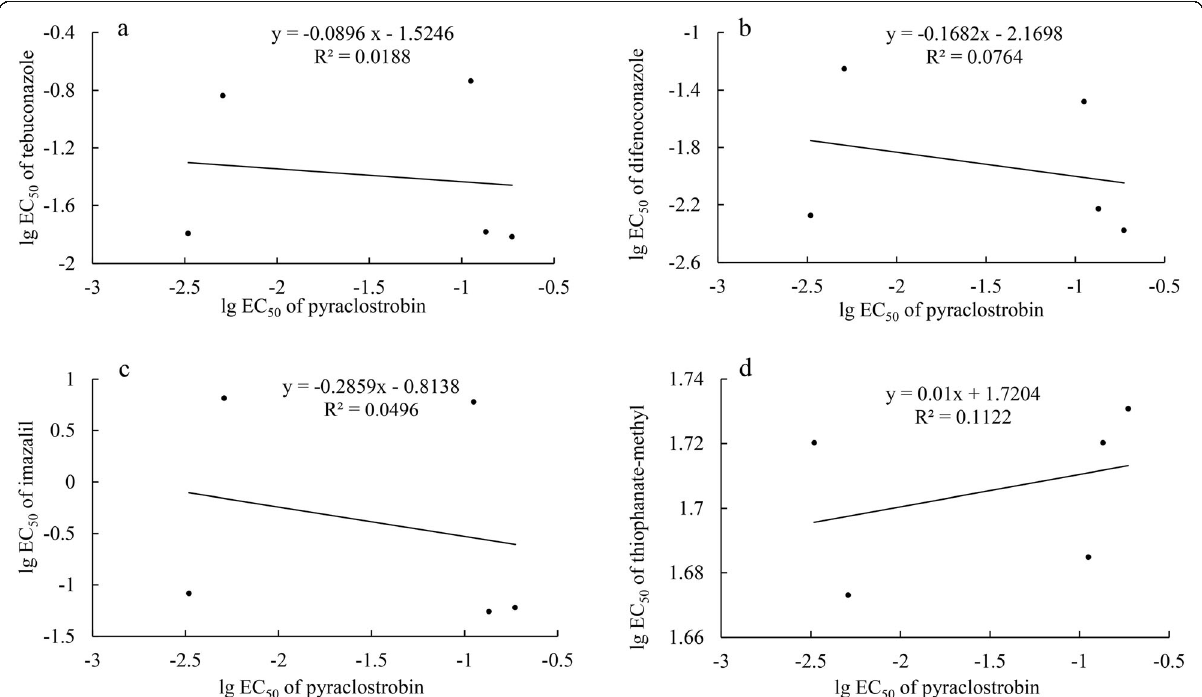
Fig. 3 Cross-resistance assays between pyraclostrobin and other four fungicides in Valsa mali . a Cross-resistance assay between pyraclostrobin and tebuconazole. b Cross-resistance assay between pyraclostrobin and difenoconazole. c Cross-resistance assay between pyraclostrobin and imazalil. d cross-resistance between pyraclostrobin and